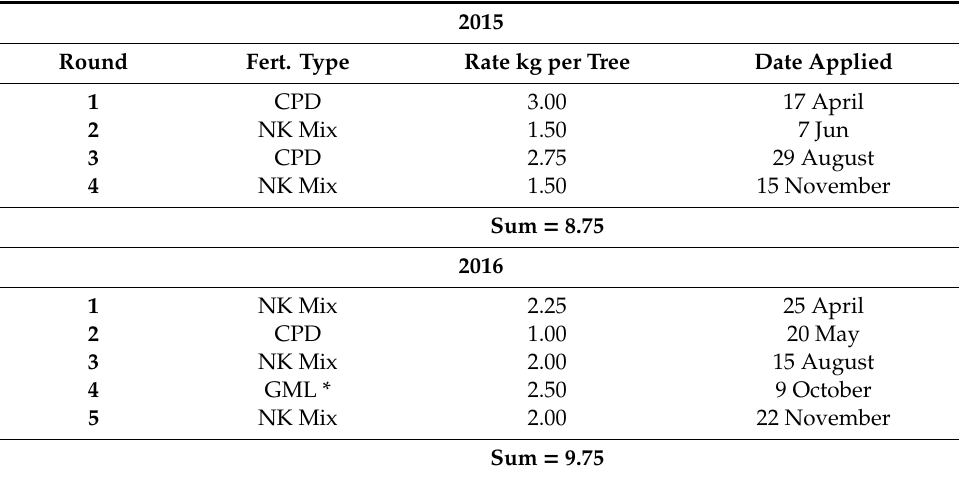
Table 3. Fertilizer schedule in 2015 and